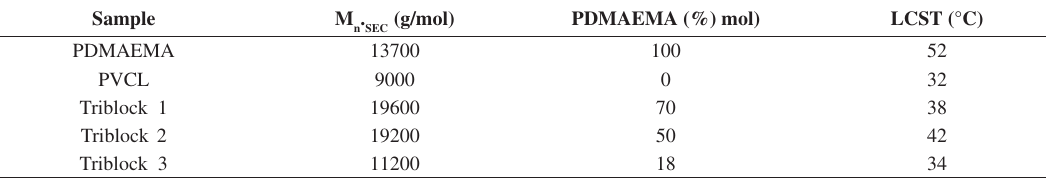
Table 2. LCST of homopolymers and different copolymers (1 wt% in water).